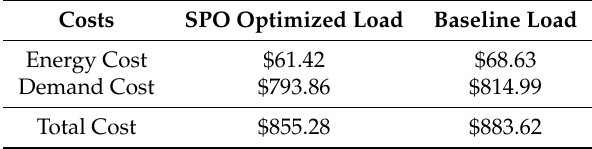
Table 4. Comparison of estimated costs for energy and demand between SPO and Baseline